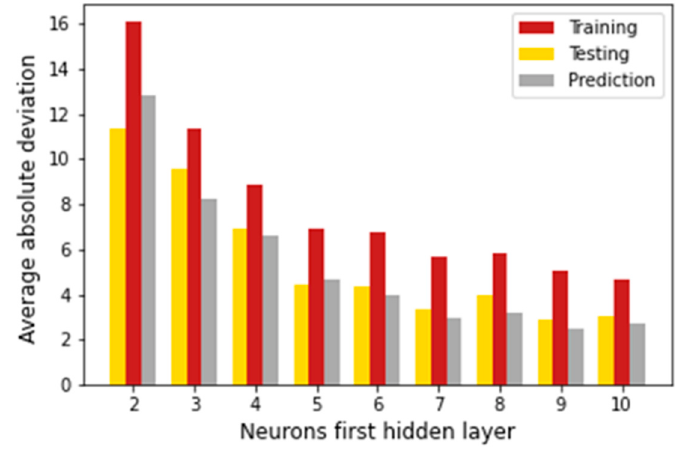
Figure 4. Optimization of the first hidden layer for architectures of type (4,m,2,1) with m = 1, 2, 3, …, 10.